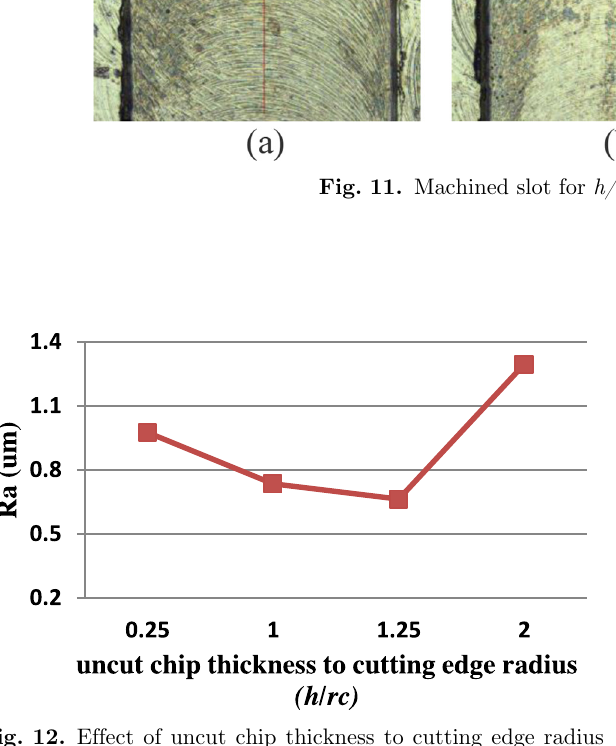
Fig. 12. Effect of uncut chip thickness to cutting edge radius ratio on surface roughness